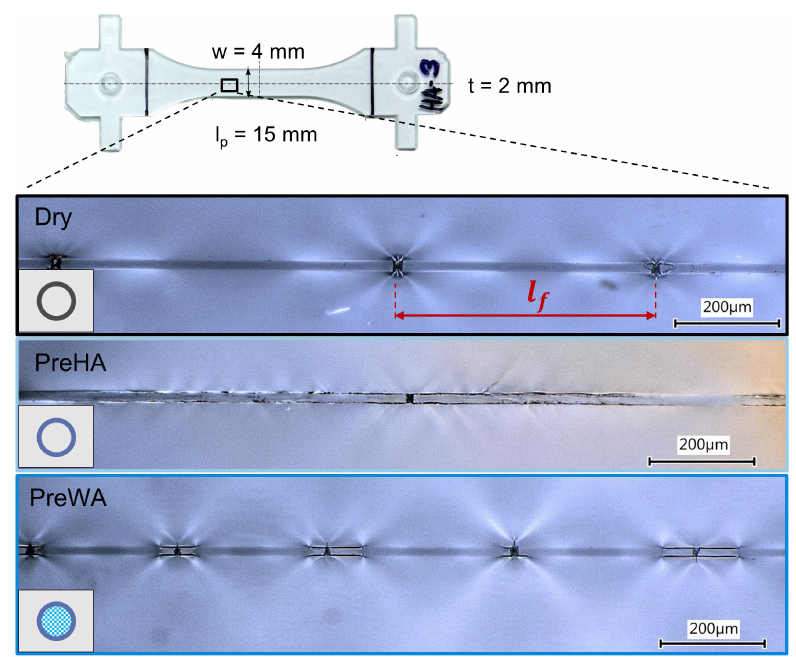
Figure 9. Single fiber fragmentation test specimen (top) and representative microscopic pictures of fiber breaks for the different aging